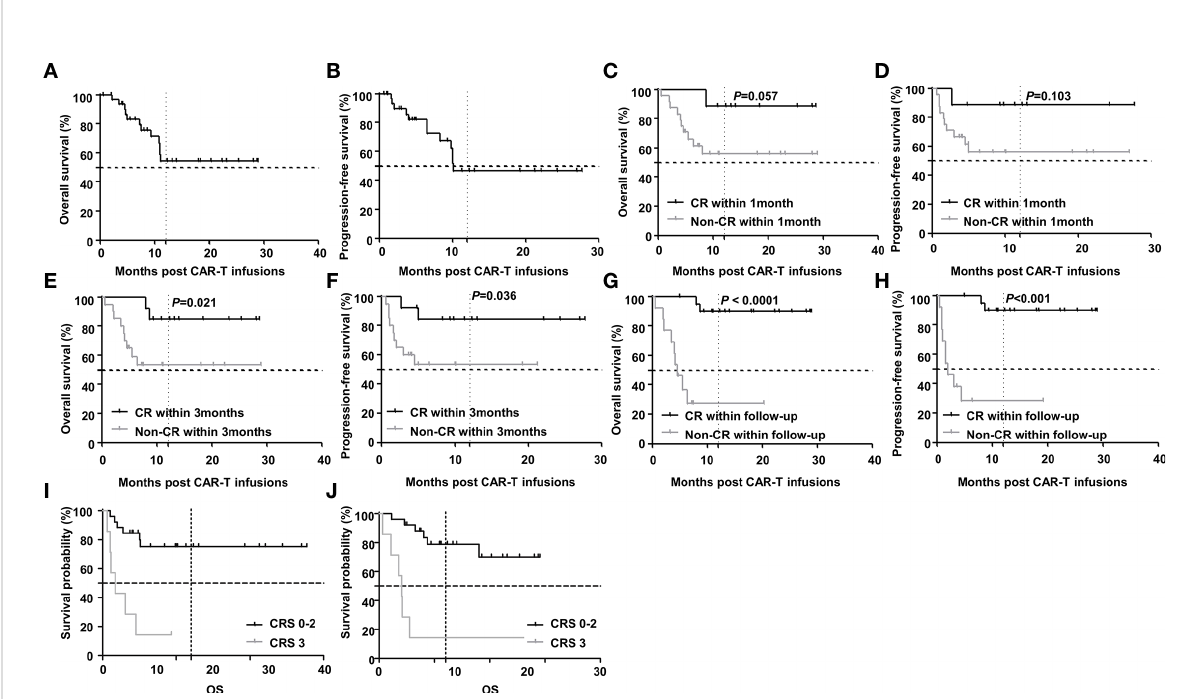
FIGURE 4 Survival after CAR-T therapy in R/R DLBCL patients. (A, B) OS and PFS curves of all patients after CAR-T therapy and the 2-year OS and PFS rates were 54.3% and 47.2% respectively (n=33). (C, D) OS and PFS curves of patients in cases who achieved CR within 1 month and those who did not. The 2-year OS and PFS in both groups were unde fi ned and unde fi ned (n1=9, n2=24, P =0.057 and P =0.103 respectively). (E, F) The 2- year OS and PFS curves of patients in cases who achieved CR within 3 months and those who did not. The 2-year OS and PFS in both groups were unde fi ned and unde fi ned (n1=13, n2=20, P =0.021 and P =0.036 respectively). (G, H) The 2-year OS and PFS curves of patients in cases who achieved CR during the follow-up period and those who did not. The 2-year OS and PFS in both groups were unde fi ned versus 4.6 months (n1=20, n2=13, P < 0.0001) and unde fi ned versus 2.0 months (n1=20, n2=13, P <0.001). (I, J) The 2-year OS and PFS curves of patients with grade 3 CRS and those with grade 0-2 CRS. The 2-year OS and PFS in both groups were 4.1 months versus unde fi ned (n1=7, n2=26, P < 0.0001) and 1.7 months versus unde fi ned (n1=7, n2=26, P =0.0002). Note: OS for overall survival; PFS for progression-free